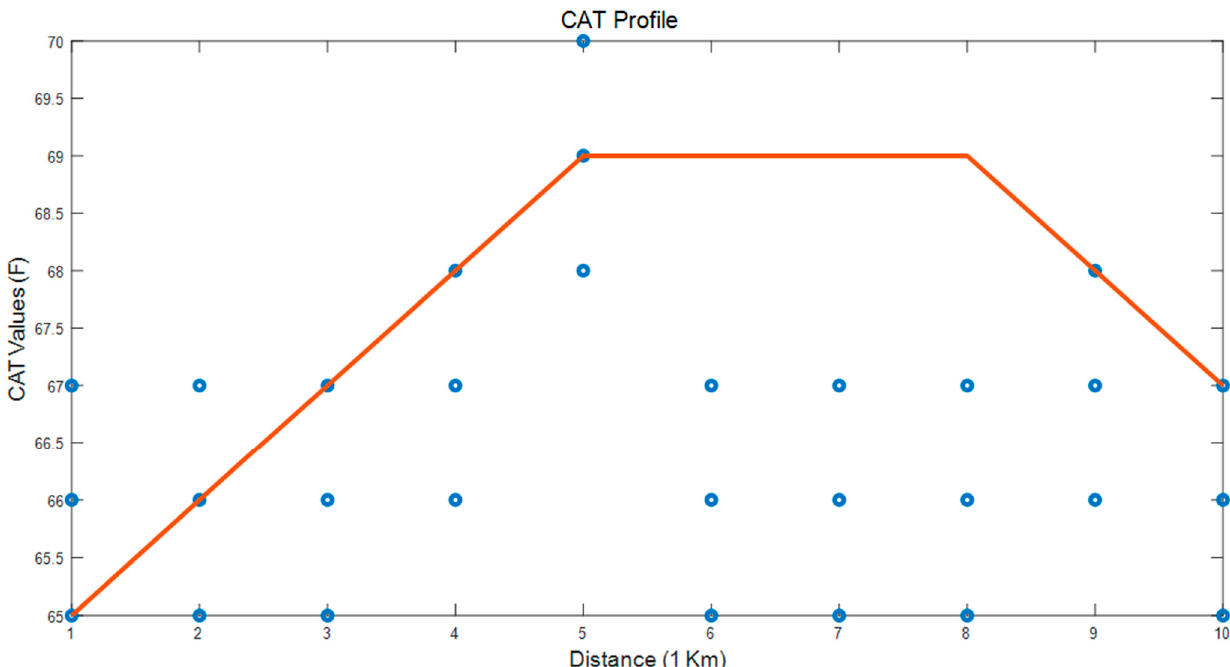
Figure 9. ACCSSP = 70 MPH; CAT = [70 75] °F; EAT = 38.3 °F.